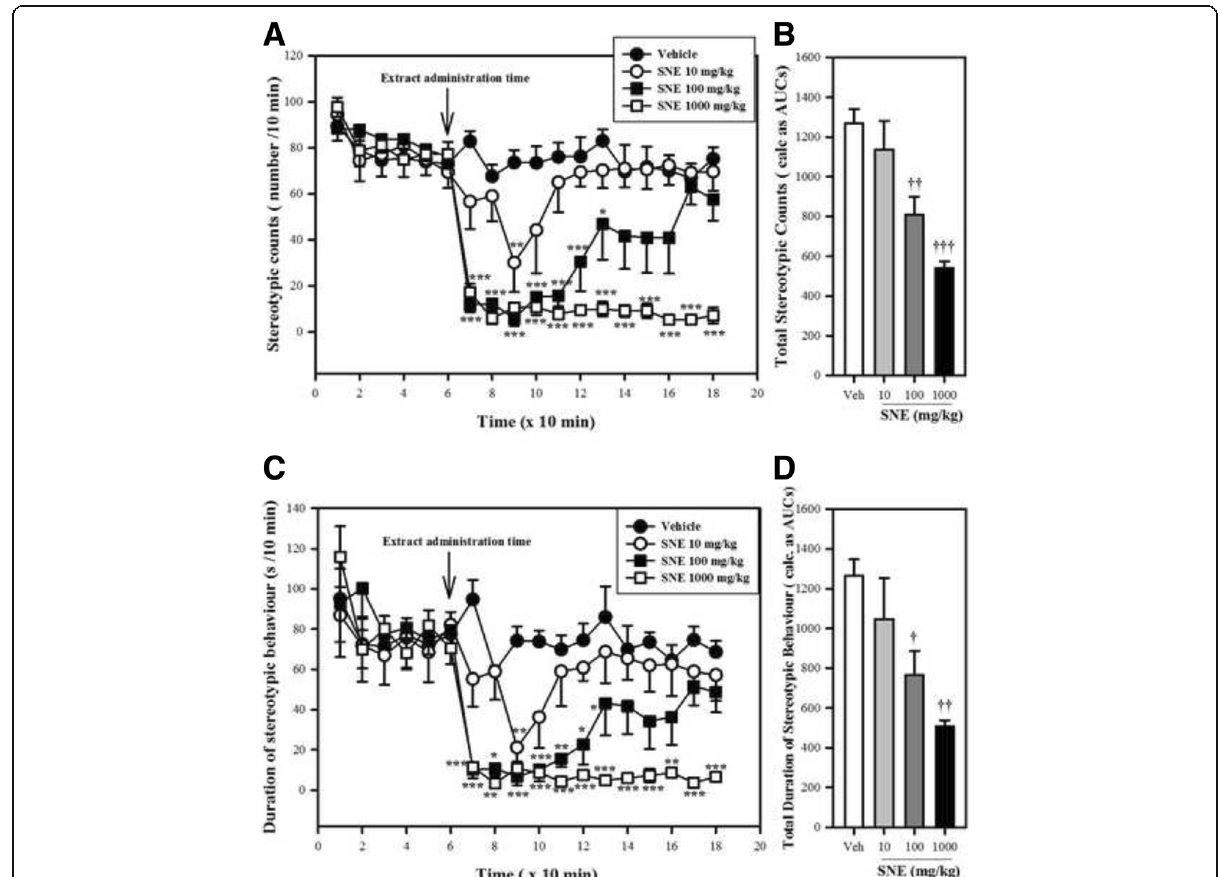
Fig. 4 Effects of SNE on the frequency ( A ) and duration( C ) of stereotypy in mice. Graphs A and C are the time-course effects of varying doses of SNE recorded over 180 min. Graphs B and D indicate the total frequency and duration of stereotypy behaviour (calculated as AUCs from the time-course graphs). Data are mean ± SEM ( n = 5). * P ≤ 0.05, ** P ≤ 0.01, *** P ≤ 0.001 compared with vehicle group (Two-way ANOVA followed by a Bonferroni ’ s posthoc test). † P ≤ 0.05, †† P ≤ 0.01, ††† P ≤ 0.001 compared with vehicle group (one-way ANOVA followed by a Dunnett ’ s multiple comparison post hoc